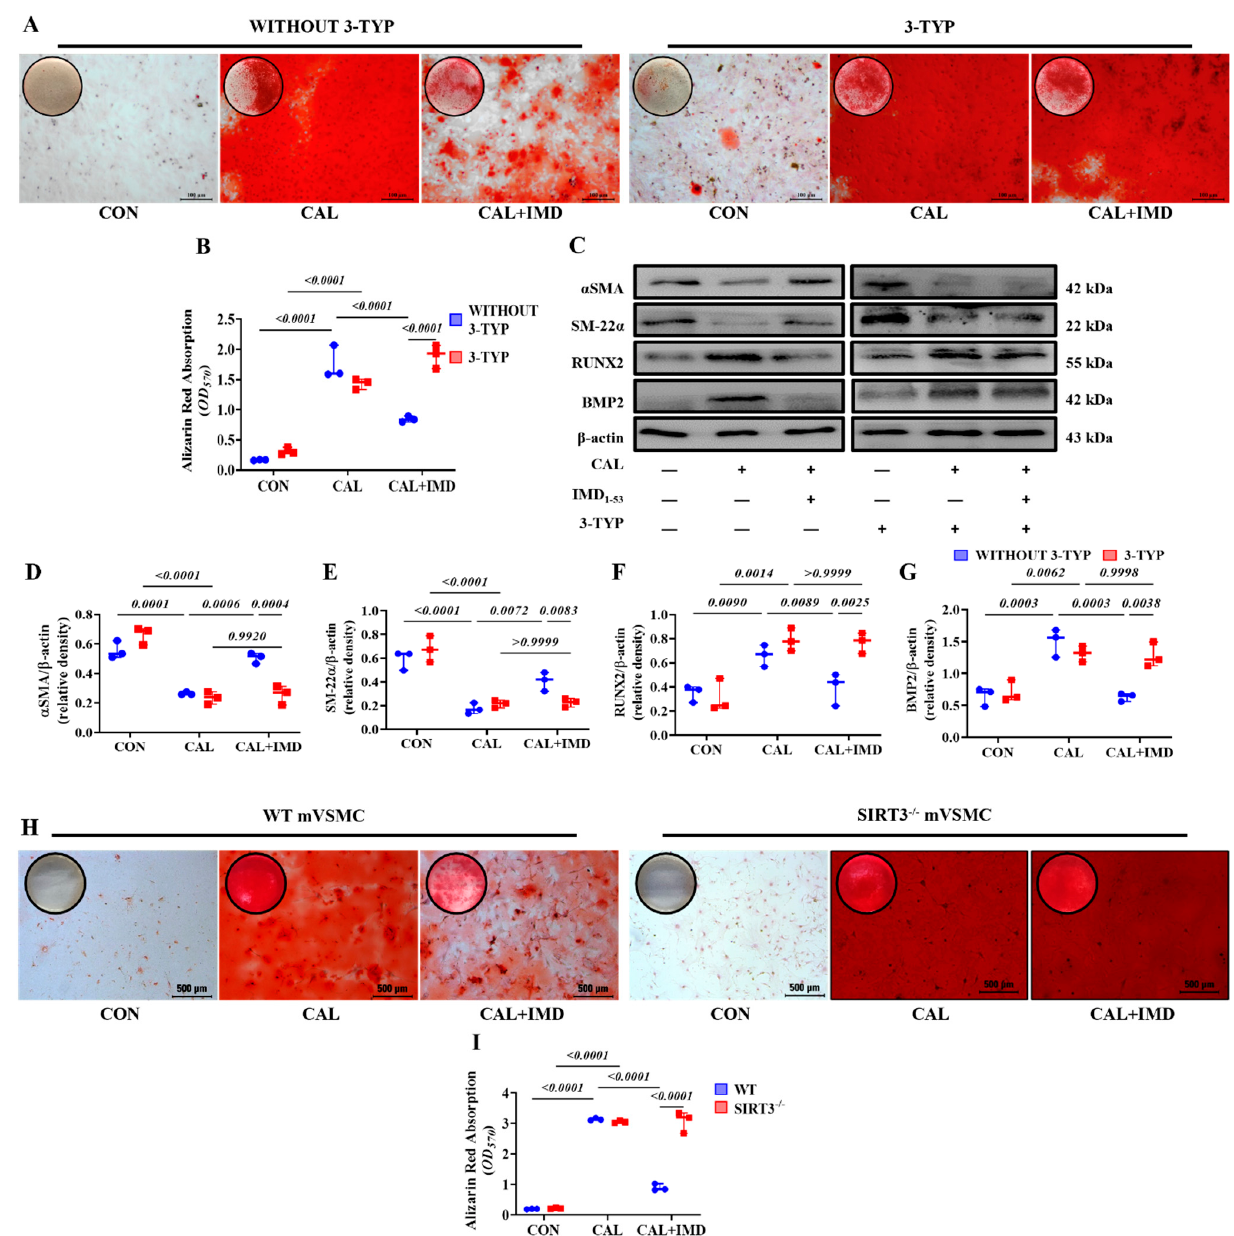
Figure 4. Sirt3 mediated IMD inhibition of vascular calcification. Alizarin red staining (positive staining: red) of ( A ) rat VSMCs (Scale bar = 100 μ m) and ( H ) mouse VSMCs (Scale bar = 500 μ m) and ( B , I ) quantification ( n = 3). ( C ) Western blot analysis of the protein levels of SM22 α , α SMA, BMP2 and RUNX2 in rat VSMCs and ( D – G ) quantification ( n = 3). CON: control VSMCs, CAL: calcification VSMCs, CAL + IMD: calcification VSMCs with IMD 1-53 treatment. 3-TYP (blue circles in ( B , D – G )): VSMCs with 3-TYP pretreatment, WITHOUT 3-TYP (red squares in ( B , D – G )): VSMCs without 3-TYP pretreatment. WT (blue circles in ( I )): VSMCs from wild-type mice, SIRT3 -/- (red squares in ( I )): VSMCs from Sirt3-knockout mice. Data are mean ± SD.